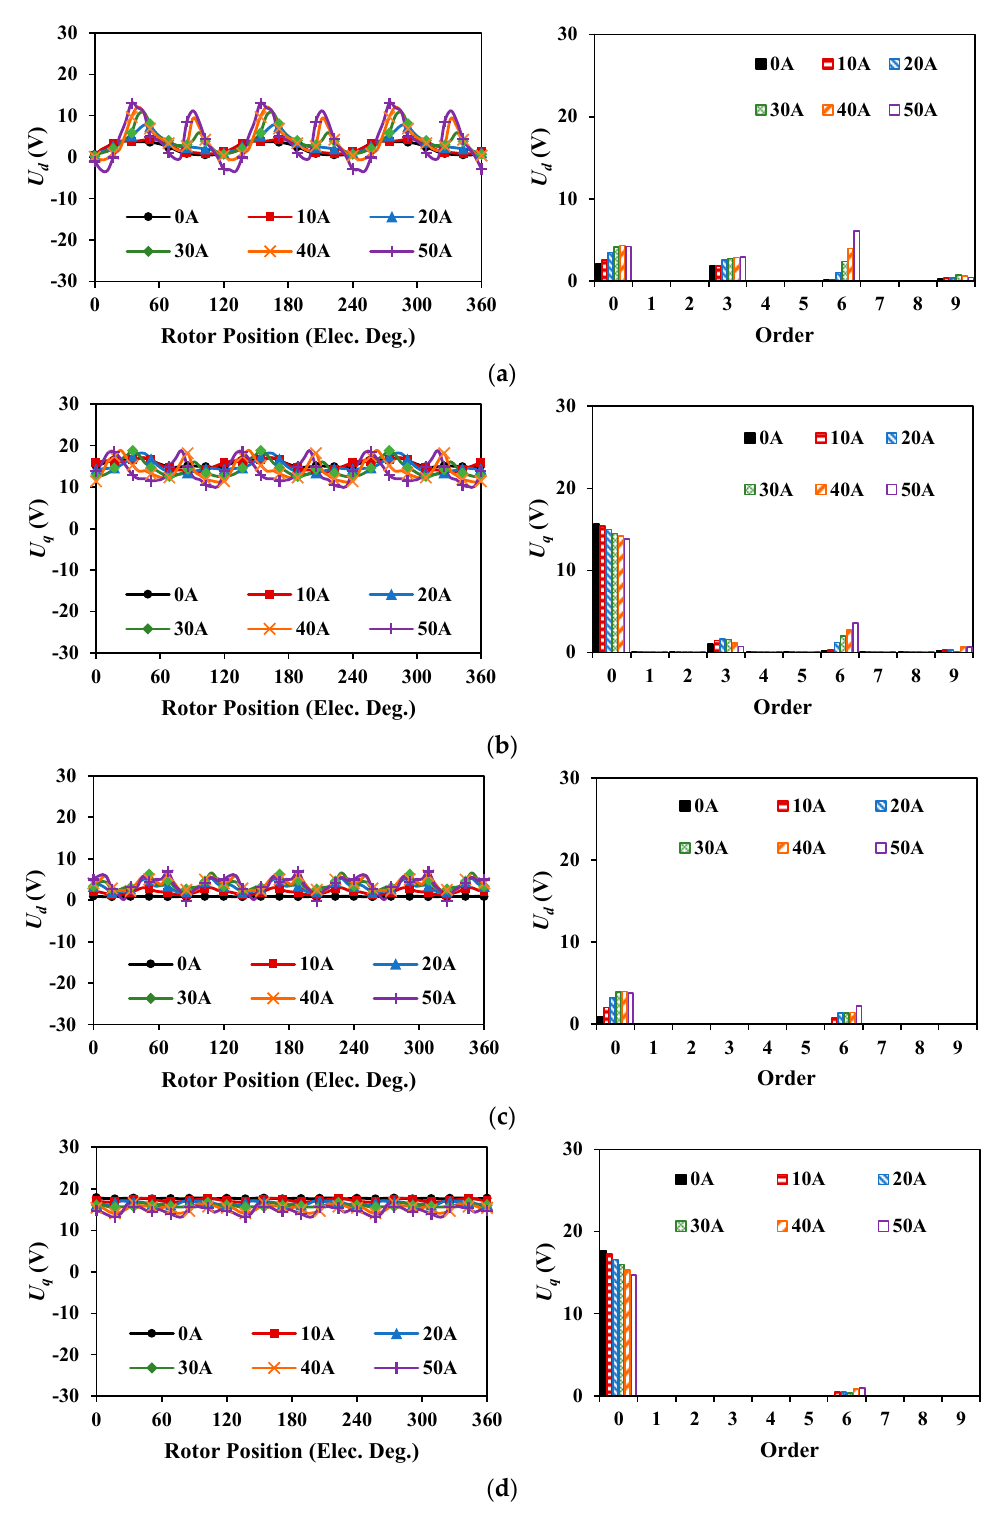
Figure 30. Back EMFs and spectra of two PSCPPM machines. ( a ) D-axis back-EMF of 12s8p-PSCPPM. ( b ) Q-axis back-EMF of 12s8p-PSCPPM. ( c ) D-axis back-EMF of 12s10p-PSCPPM. ( d ) Q-axis back-EMF of 12s10p-PSCPPM.